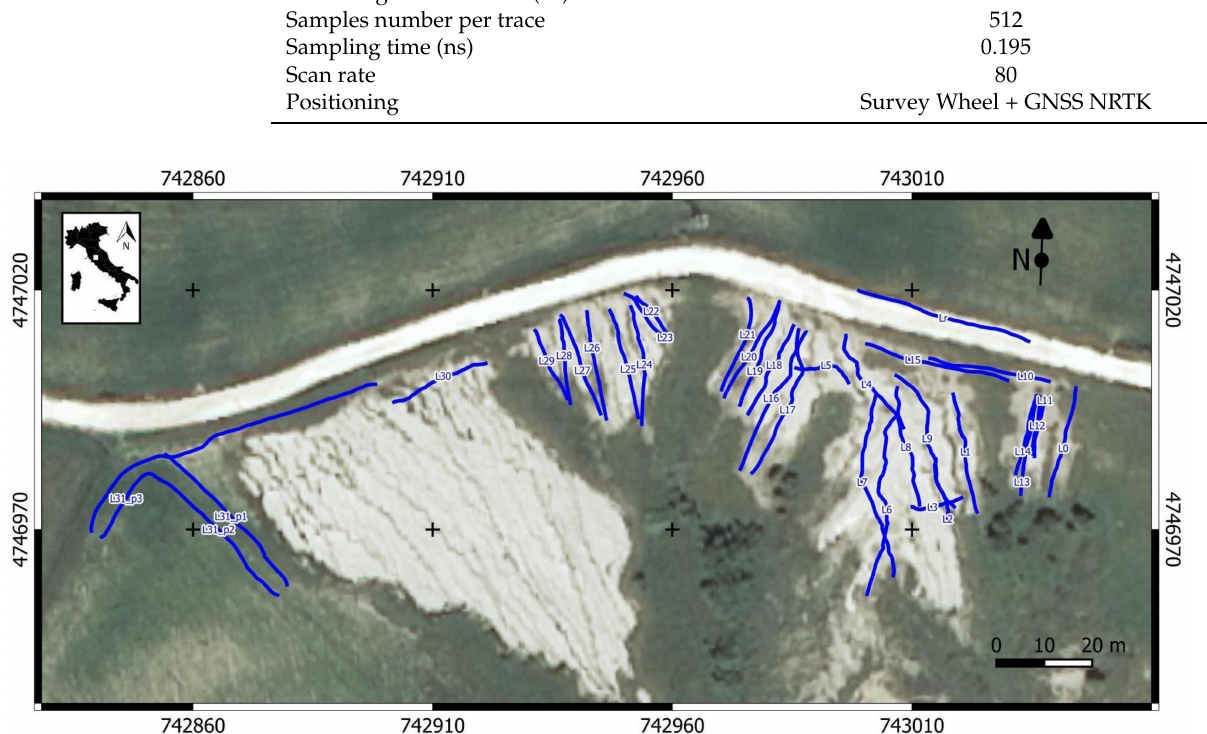
Figure 3. Tracks of the GPR profiles collected at Bargiano